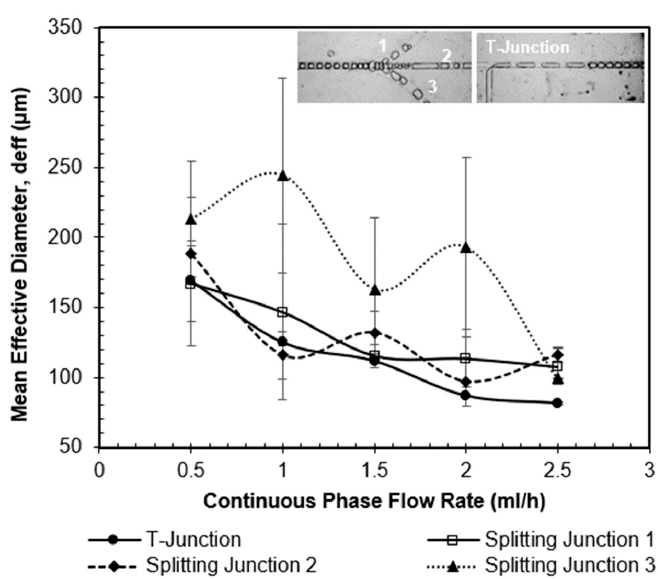
Figure 9. Average droplet size distribution with respect to different Q c ranging from 0.5 to 2.5 mL/h in symmetrical bifurcating junction. Image indicates the region of interest for the droplet measurement. Error bars indicate the standard deviation in effective droplet size measurement of 30 droplets under fixed experimental condition.